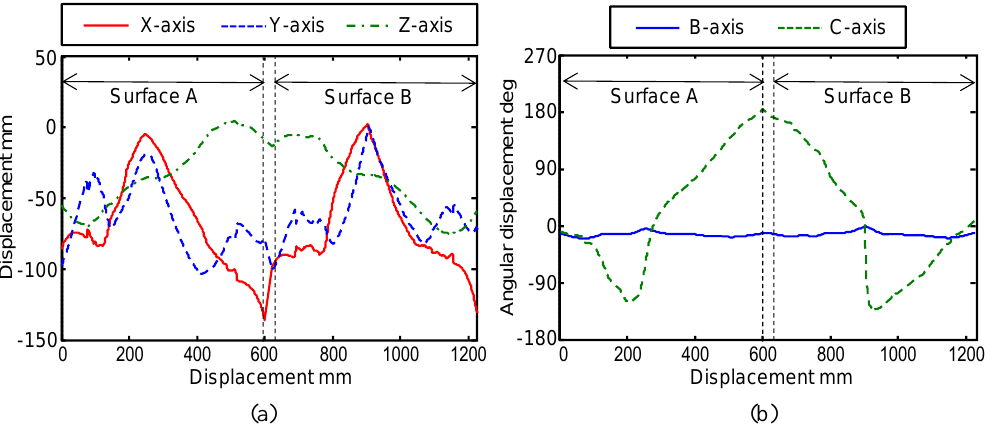
Figure 6. Motion of each axis during the proposed S-shaped machining: ( a ) Motion of translational axes; ( b ) Motion of rotary axes.